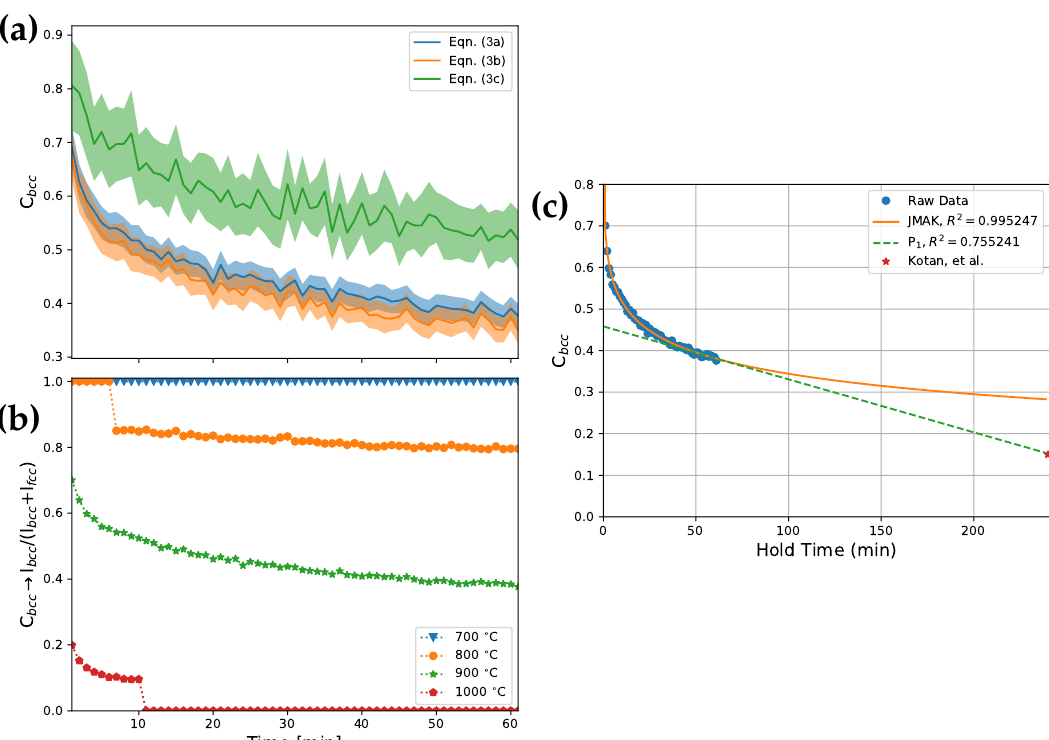
Figure 3. Approximation of the retained α phase at different hold times. ( a ) different methods were tested to determine which method is more reliable, ( b ) the resulting phase evolution at the different isothermal conditions, and ( c ) fit to the 900 ◦ C estimated phase evolution, which is compared to the result by Kotan et al. The linear fit was performed using the last 17 min of the current